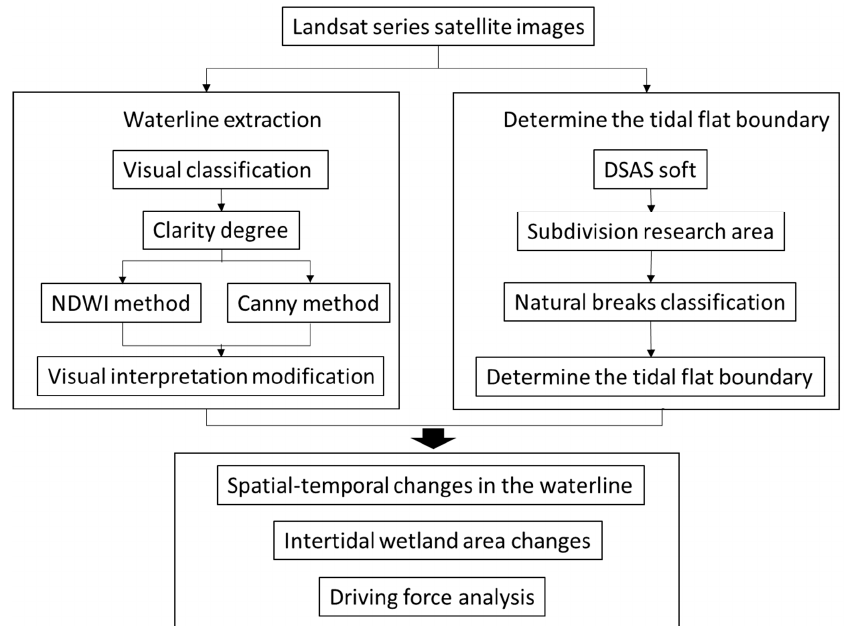
Figure 5. Data processing and analysis flow chart. DSAS: Digital Shoreline Analysis System.